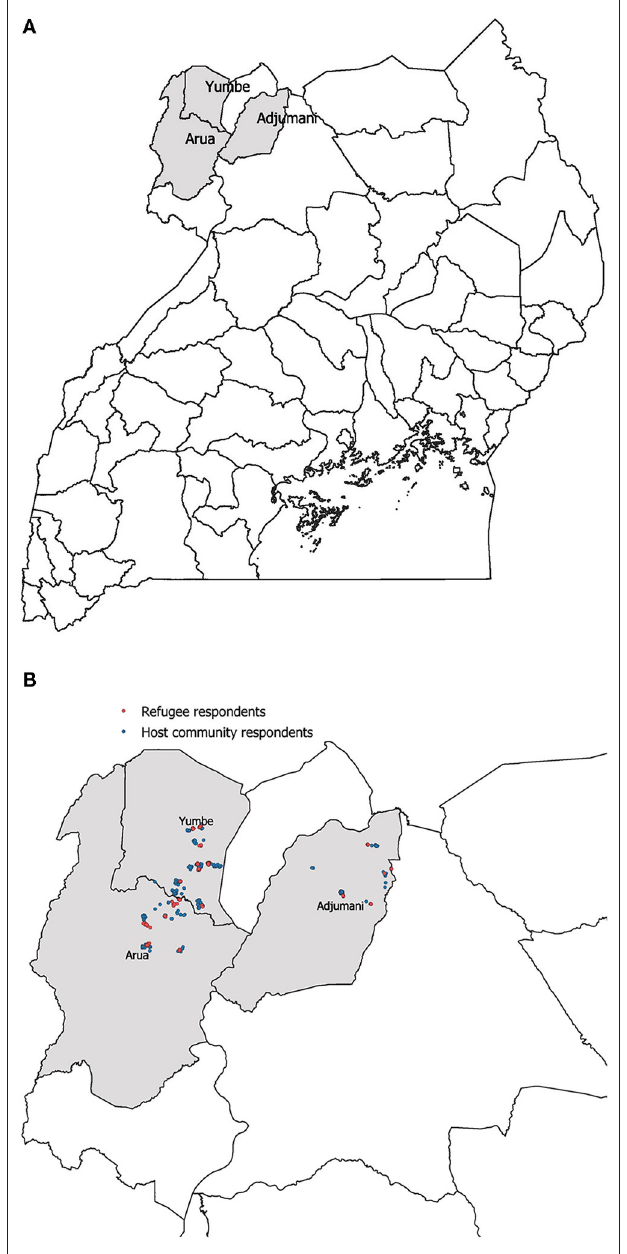
FIGURE 1 | Map over districts (A) and geo-location of respondents (B)